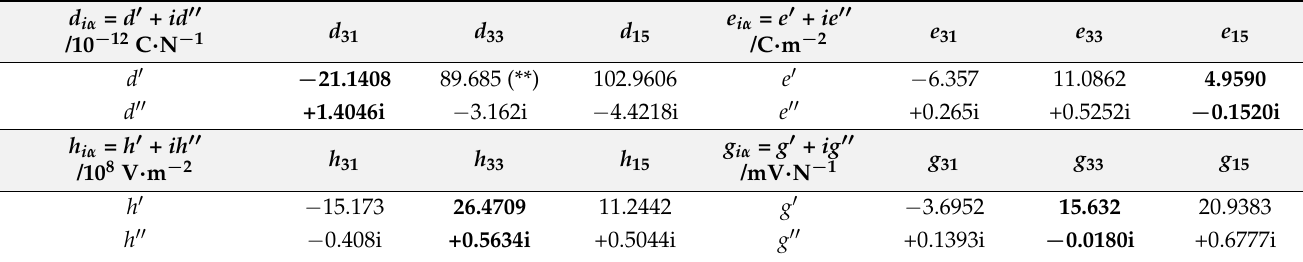
Table 2. Complex piezoelectric coefficients of the PIC700 eco-piezoceramic ( * ) .